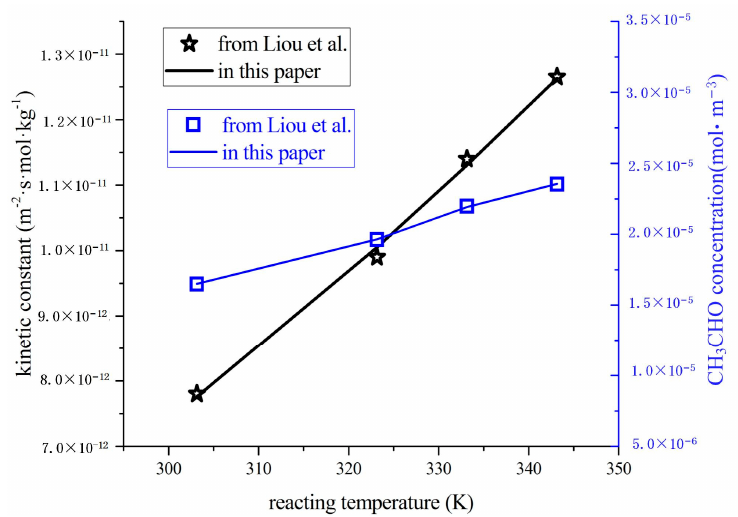
Figure 7. Verification of the kinetic model with temperature effects.